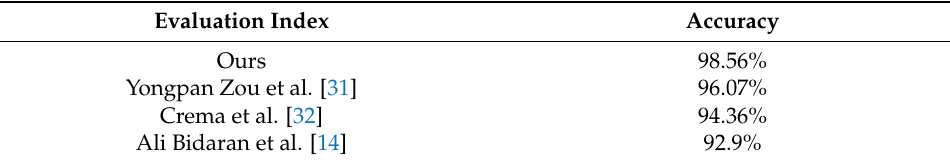
Table 15. Comparison of accuracy of fitness movement